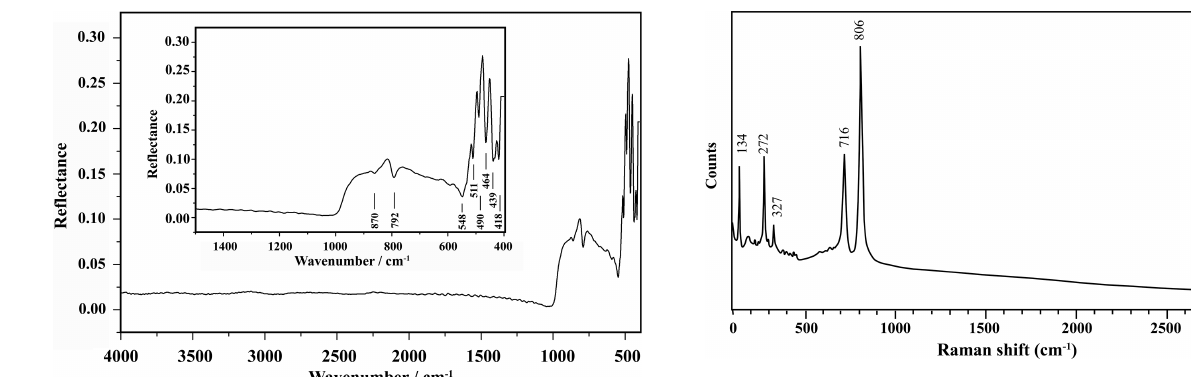
Figure 3. The IR spectrum of liguowuite.